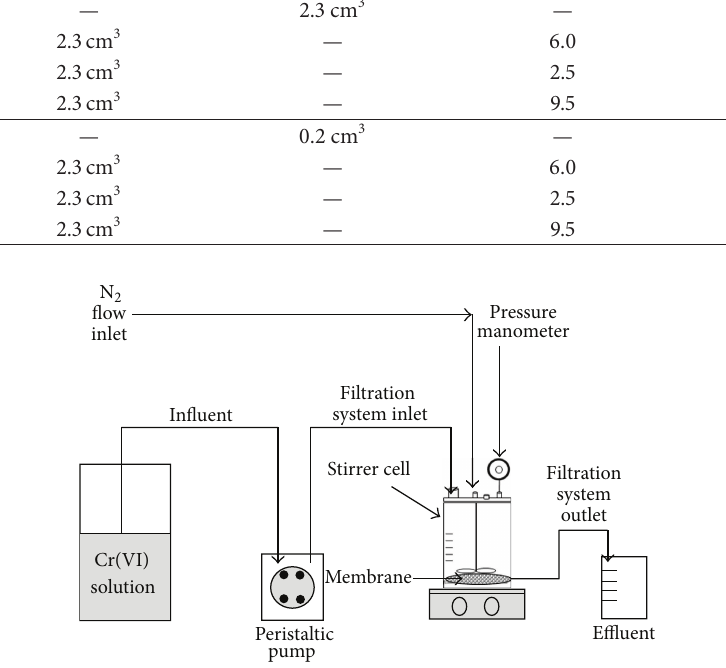
Figure 1: Filtration system by continuous